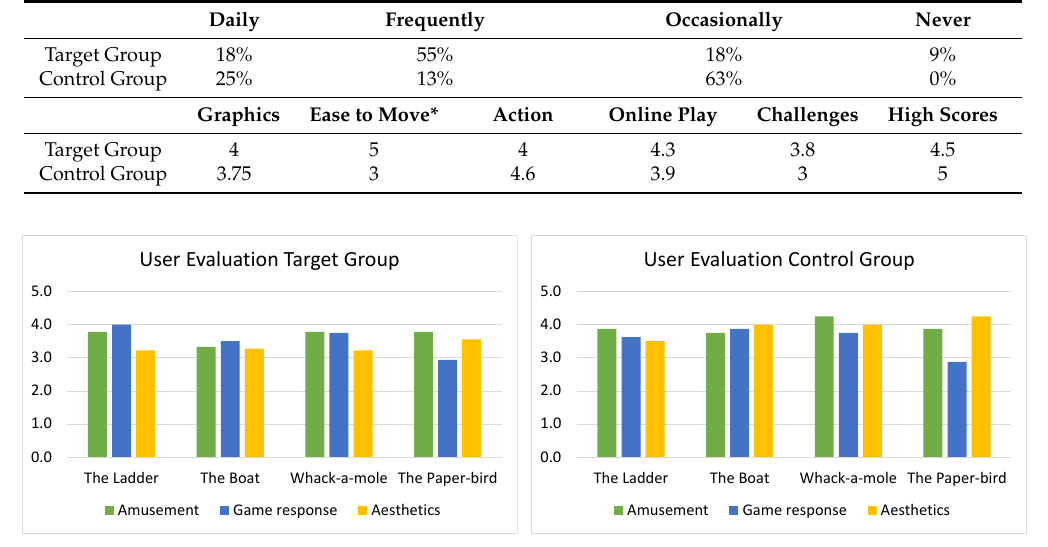
Figure 9. Outcome of the Survey, Part 2—Evaluation of Tested Games.